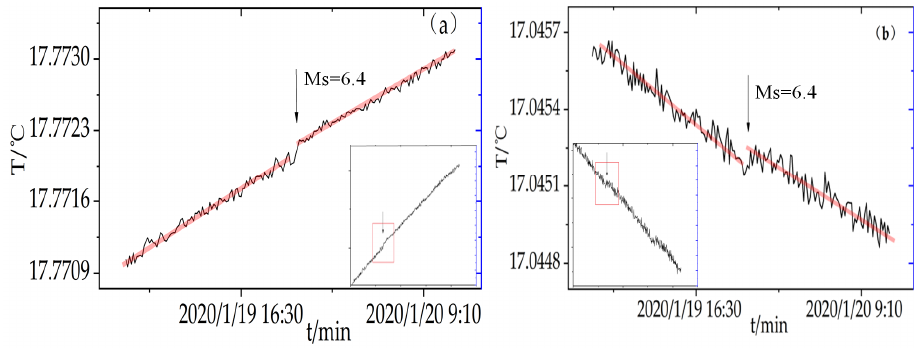
Figure 3. Geothermal time series of 12.3 m ( a ) and 22.8 m ( b ) layers at XKE.